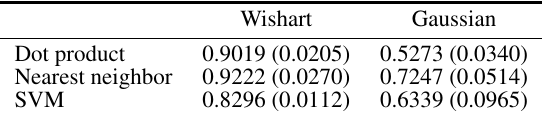
Figure 6. Mean accuracy and standard deviation measured on the SFB subset for different choices of K . In blue for eFV based on Wishart distribution and in green for eFV based on Gaussian distribution. Similarity measures are dot product (DP), support vector machines (SVM) and nearest neighbors (NN).